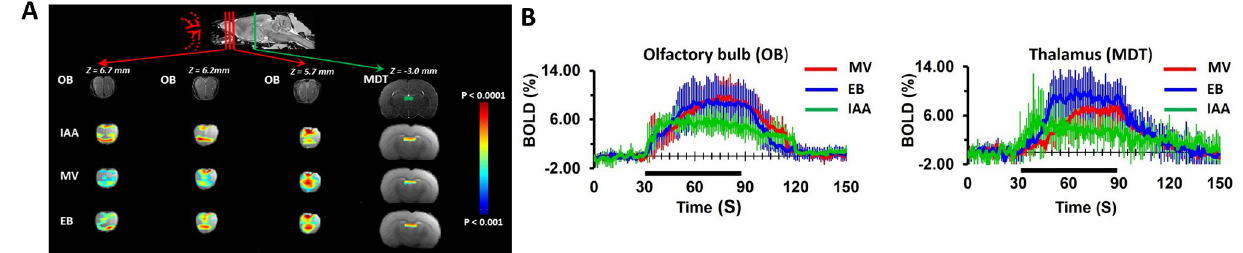
Fig 4. Odor stimulation-induced activation of rat Olfactory Bulb (OB) and thalamus revealed by high-field (11.7T) fMRI (8 rats, 24 trials). To correlate activations in OB and thalamic regions, reference stereotaxic atlas images were overlaid on the corresponding anatomical images shown in the top row ( A ). BOLD activations were observed in the OB and medial dorsal thalamic nuclei (MDT) during different odors stimulation (IAA: isoamyl acetate, MV: methyl valerate, EB: ethyl butyrate. BOLD activation maps were calculated during 1 minute odor stimulation. BOLD activation maps, displayed as colored statistical maps (a 2-sample, unpaired, T-test with equal variance and one tail for stimulation (60s) > baseline (30s)) overlaid on the corresponding anatomical images. Coronal slices corresponding to OB are positioned 6.7 mm, 6.2 mm, 5.7 mm anterior to bregma and 3 mm posterior to bregma for MDT. B : The mean ± SD time course of BOLD activations at OB and MDT regions for different odors were shown.